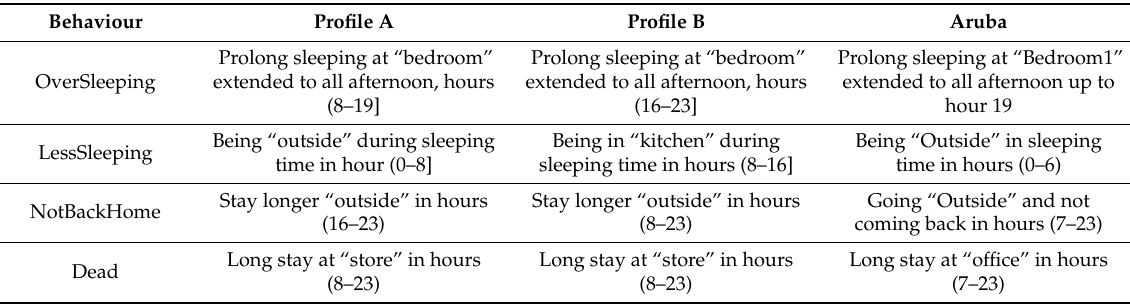
Table 7. Description of the Injected Abnormal Behaviours in the datasets.